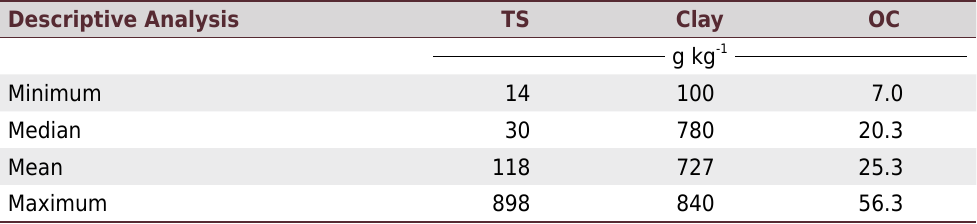
Table 4. Amplitude and descriptive analysis of data from 88 soil samples, 0.00-0.05 and 0.10-0.15 m layers, from a Latossolo Amarelo (Xanthic Oxisols), National Forest of Tapajós, Amazon